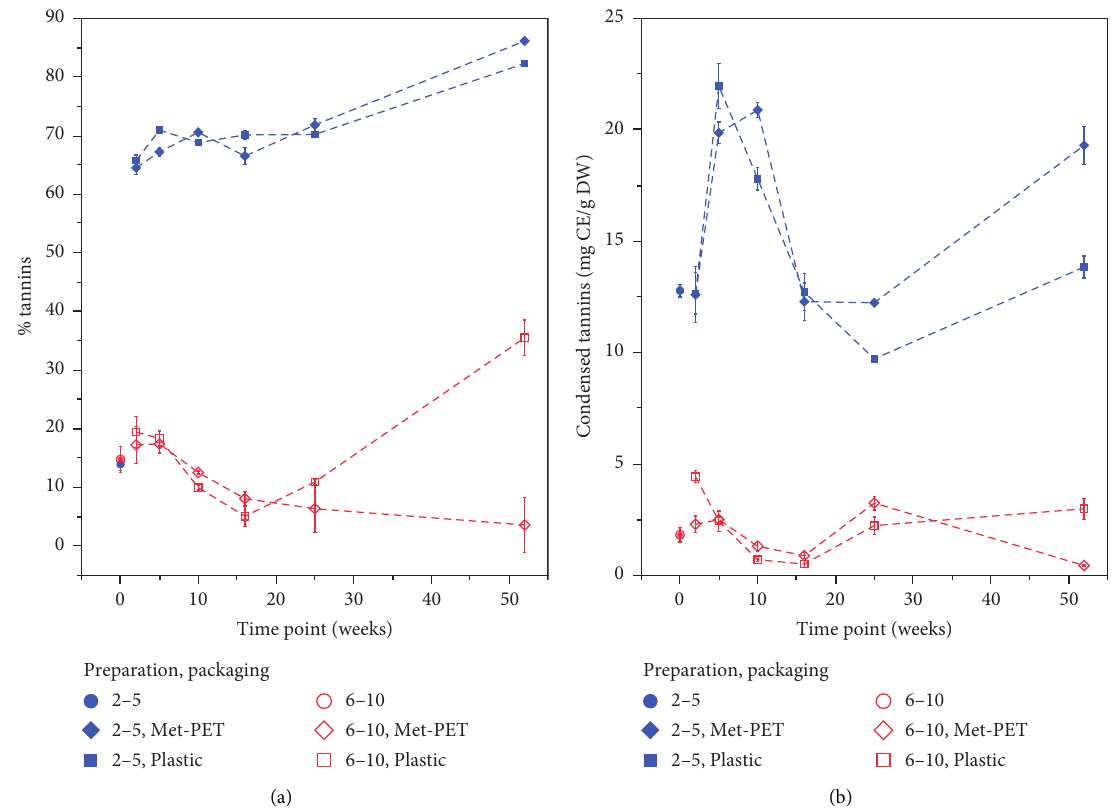
Figure 3: Mean levels of the (a) % tannins and (b) condensed tannins of the persimmon chips over the 1-year course of the storage study. Each error bar is constructed using 1 standard error from the mean. CE � catechin equivalents; DW � dry